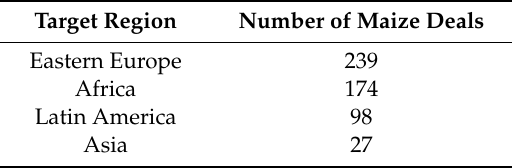
Table 2. Number of land deals for maize production. Target